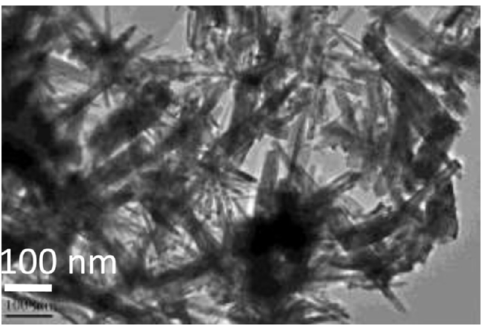
Figure 9. TEM image of IrO 2 nanorods obtained through the molten salt method (Reprinted/adapted with permission from Ref. [106]).